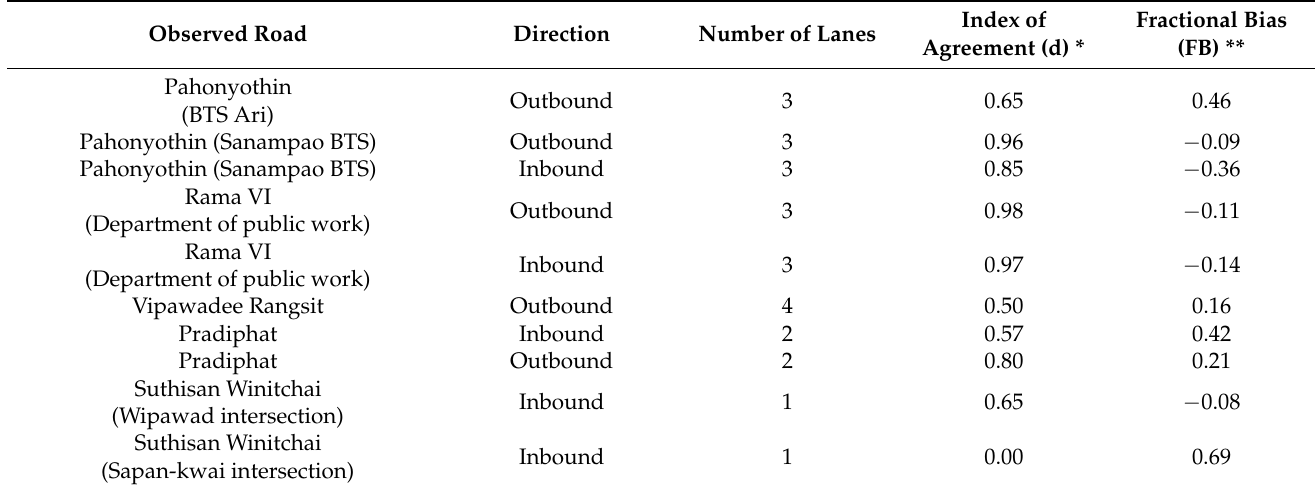
Table 3. The result of the traffic model